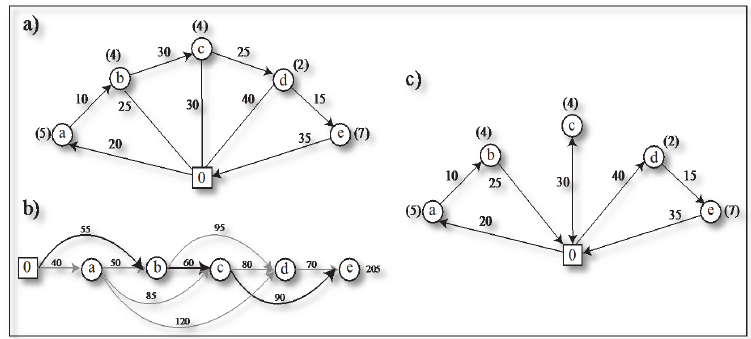
Fig. 2. Splitting procedure applied to the